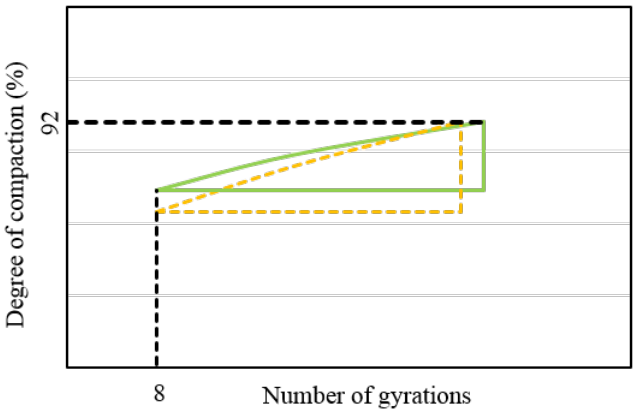
Figure 2. Di ff erent curves with an equal CEI Figure 2. Different curves with an equal CEI value.